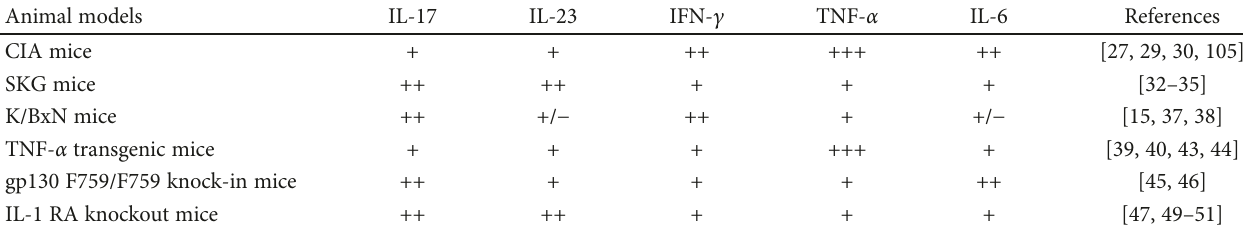
Table 1: Main features of animal models of rheumatoid arthritis regarding proin fl ammatory cytokines, including IL-17. Animal